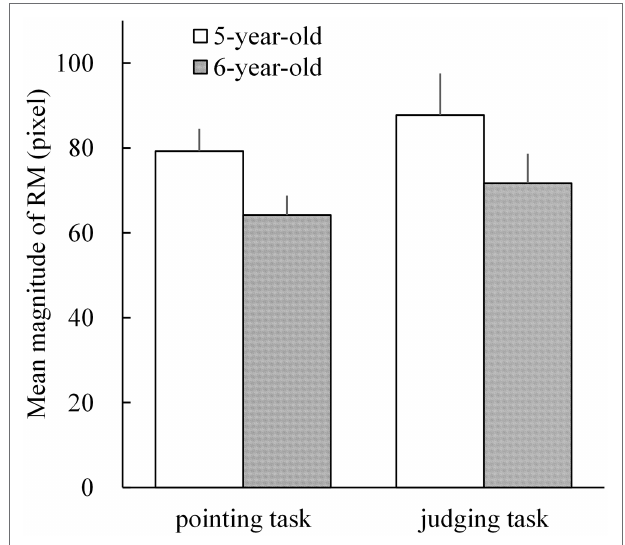
FIGURE 3 | The mean magnitudes of representational momentum (RM) in 5- and 6-year-old children for the pointing and judging tasks. Individual magnitude of RM was calculated by subtracting the individual mean displacements (pointing errors in the pointing task; and points of subjective equality, PSE, in the judging task) under the delayed-vanishing condition from those in the immediate-vanishing condition. The error bars present 1 standard